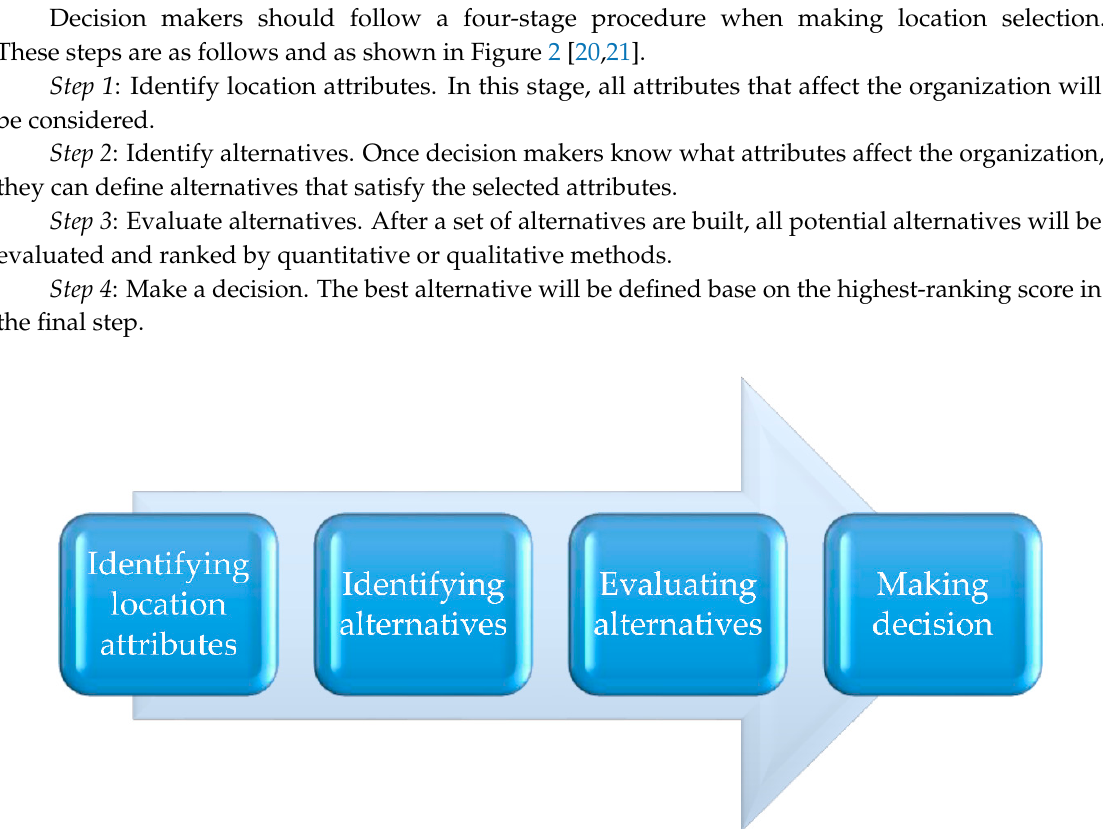
Figure 1. A generic process of multi-criteria decision making (MCDM).